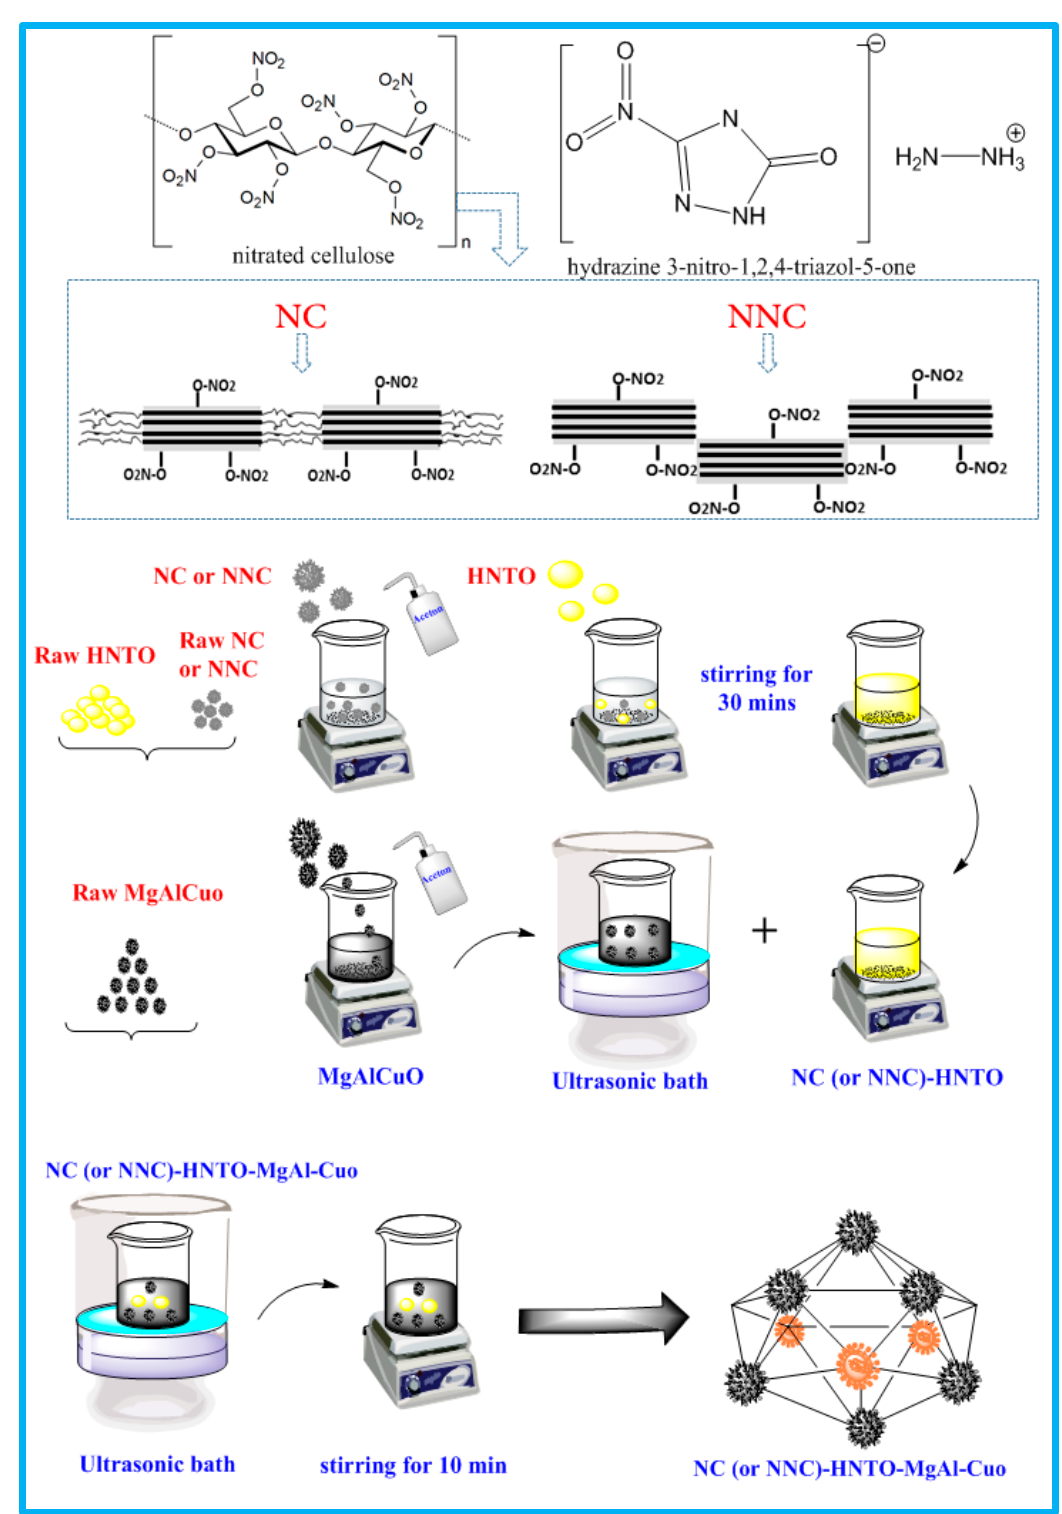
Figure 8. Preparation process of NC (or NNC)/HNTO/MgAl-CuO